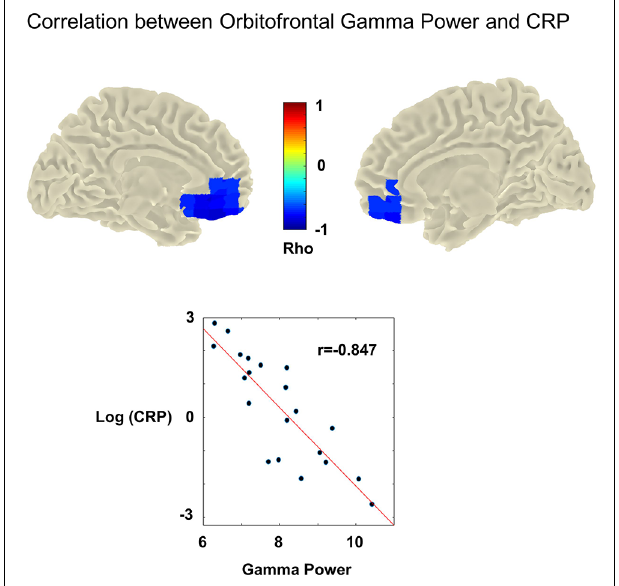
FIGURE 2 | Upper panel: cluster statistic showing a significant correlation between high gamma power (60–90 Hz) and C-reactive protein levels (CRP) across participants with chronic tinnitus (cluster- p = 0.001, Benjamini-Hochberg adjusted p -value = 0.006). No MEG data was available for the control group. In the tinnitus group, high CRP levels are associated with significantly reduced gamma power (60–90 Hz). This effect is strongest in the left and right orbitofrontal cortices (most prominent correlation in left and right A11 lateral). Lower panel: association between CRP [y-axis: log(CRP)] and mean gamma power (x-axis: Gamma power/noise estimate) retrieved from the obtained significant cluster (averaged over the left and right hemisphere). Dots indicate the individual participants. The red line denominates the least-squares line. Higher CRP values are correlated significantly with reduced gamma power (Pearson’s correlation rho = − 0.847, cluster-p = 0.001, Benjamini-Hochberg adjusted p-value =